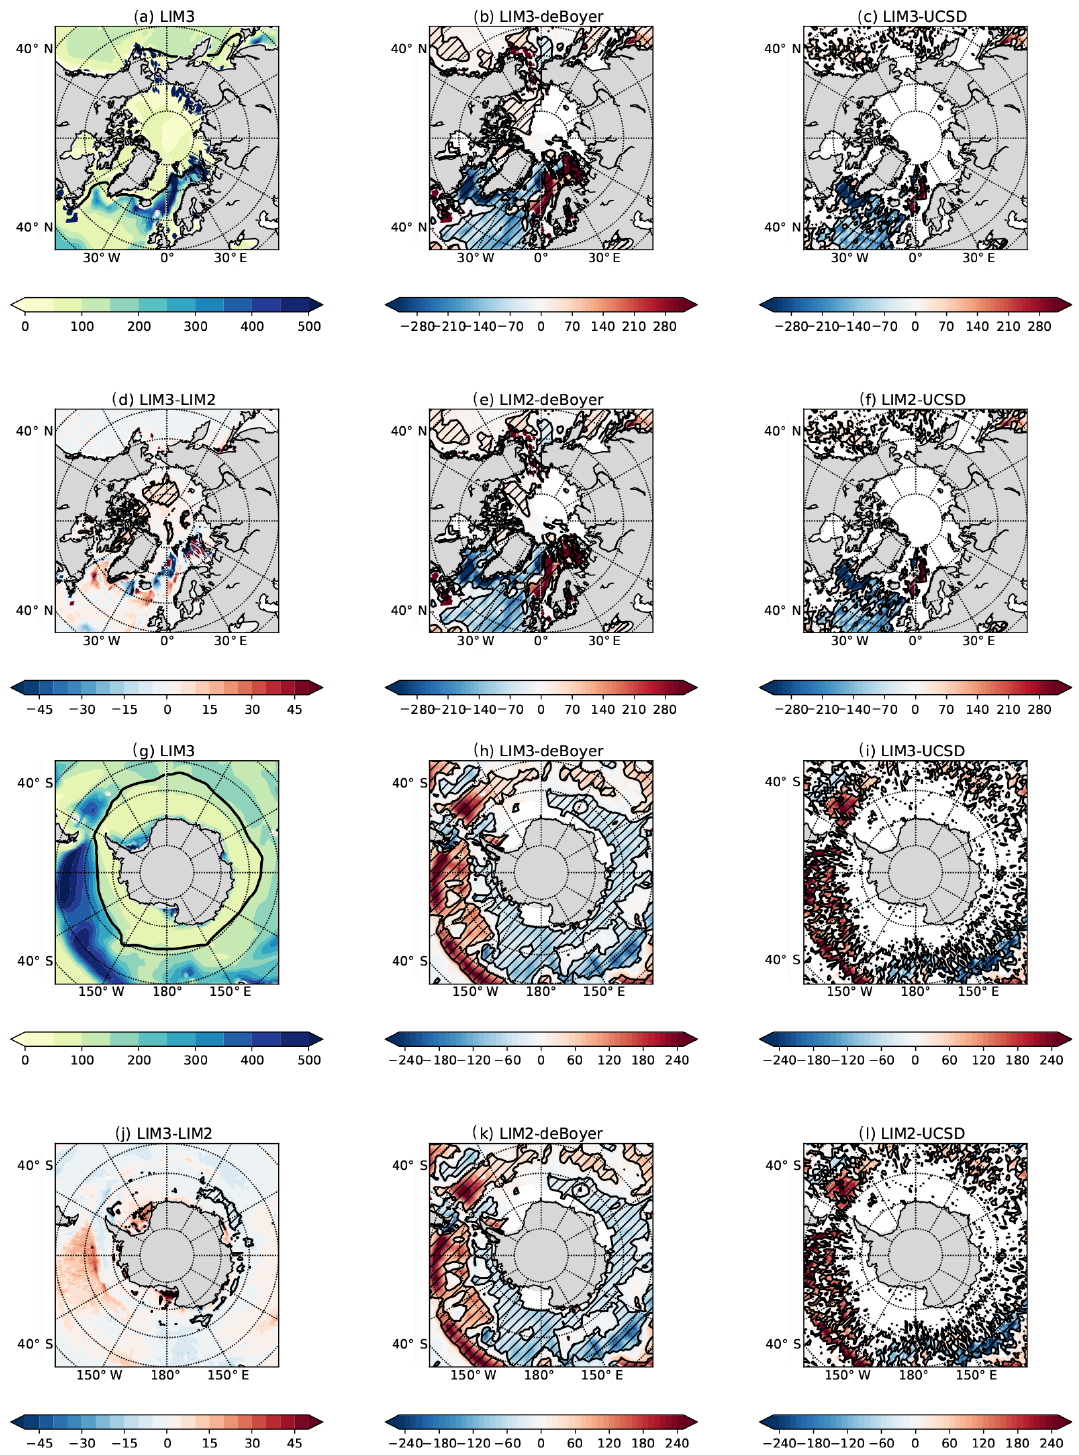
Figure 9. (a, g) mixed layer depths (in metres) as simulated by NEMO-LIM3, their departures from the observed climatologies of de Boyer Montégut et al. (2004) (b, h) and Holte et al. (2016) (c, i) , the corresponding departures for NEMO-LIM2 (e, f, k, l) and differences between LIM3 and LIM2 (d, j) . Top two row panels (a–f) represent March averages in the Northern Hemisphere (NH) and bottom two row panels (g– l) present September averages in the Southern Hemisphere (SH). Monthly averages were calculated from 2003 to 2012. Mixed layer depths are based on the potential density threshold value difference of 0.03kgm − 3 from the density value at 10m depth. In (a, g) , thick black lines show the LIM3 sea-ice edge as the 15% sea-ice concentration isopleth. Hatching indicates regions with statistically significant differences at the 5% level based on unequal variances t